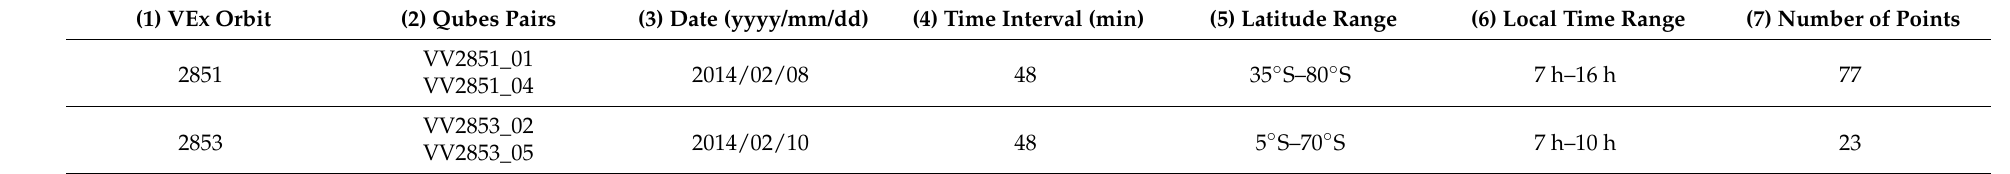
Table 2. ESA Venus Express (VEx)/Visible and Infrared Thermal Imaging Spectrometer (VIRTIS-M) UV-visible channel for 380 nm observation circumstances: (1) orbit number; (2) VEx-VIRTIS hyperspectral images or "Qubes” pairs as defined by Cardesín [44]; (3) UT date; (4) time interval between selected image pairs; (5–6) corresponding latitude and local time range; the imaging spatial resolution varies between 15 km per pixel for polar latitudes and about 45 km per pixel for equatorial ones; (7) number of cloud tracers identified in image